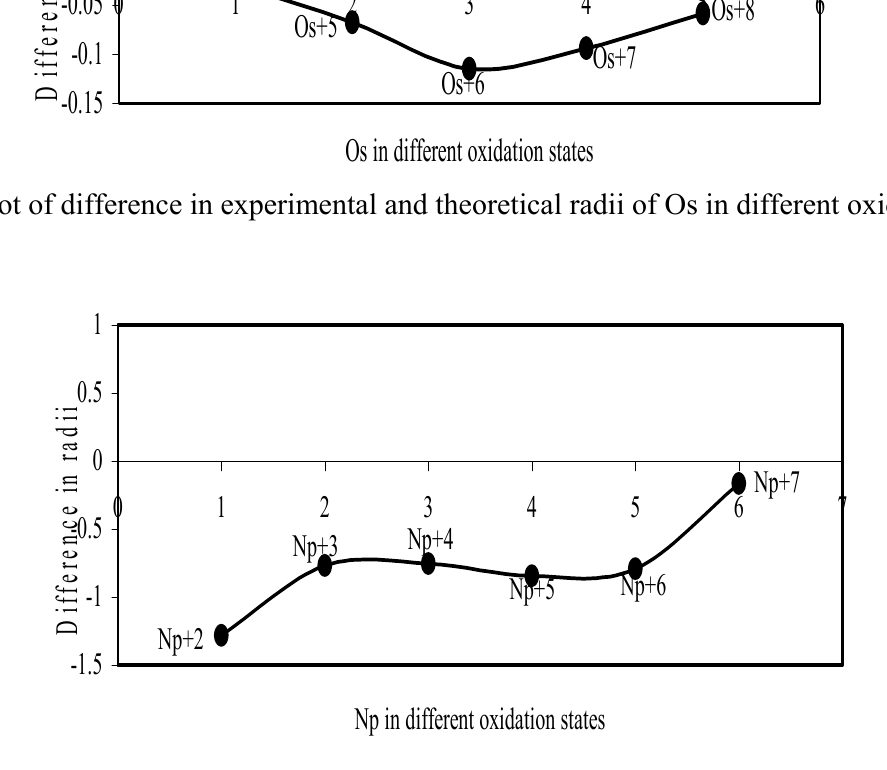
Figure 23. Plot of difference in experimental and theoretical radii of Np in different oxidation